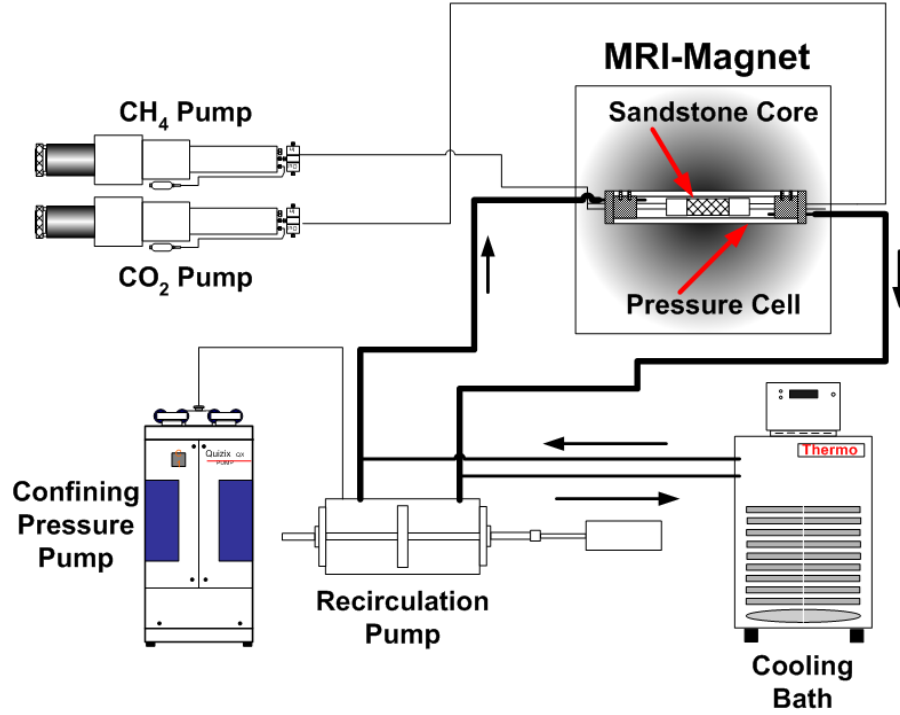
Figure 2. Illustration of the experimental setup applied for the majority of this